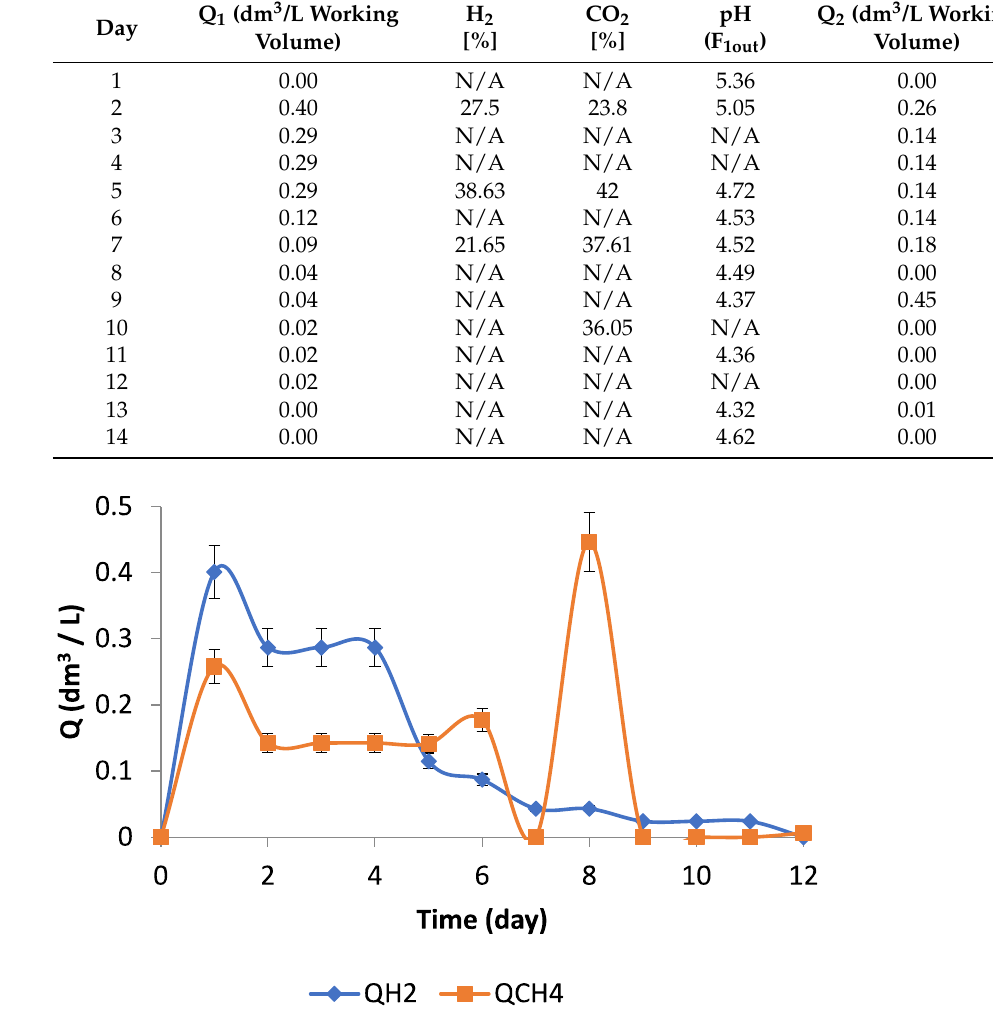
Table 4. Daily biogas production and hydrogen content from two-phase anaerobic digestion with hydrogen (BR 1 ) and methane (BR 2 ) production.